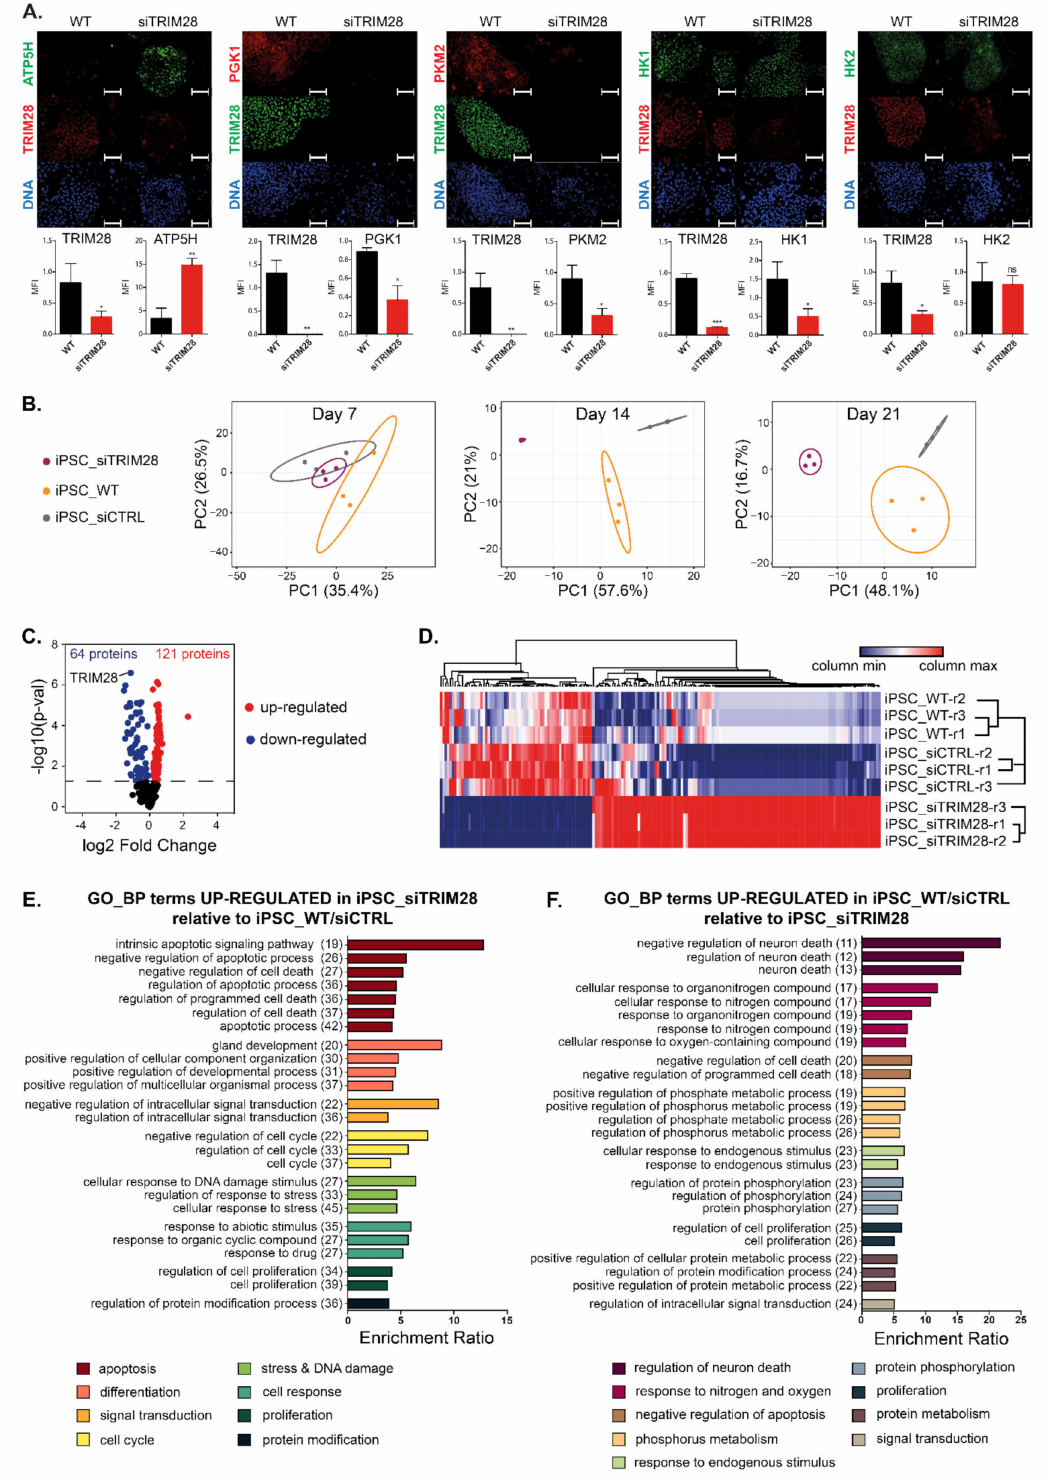
Figure 2. IPSC with silenced TRIM28 display metabolic changes and their proteomic profile differs significantly